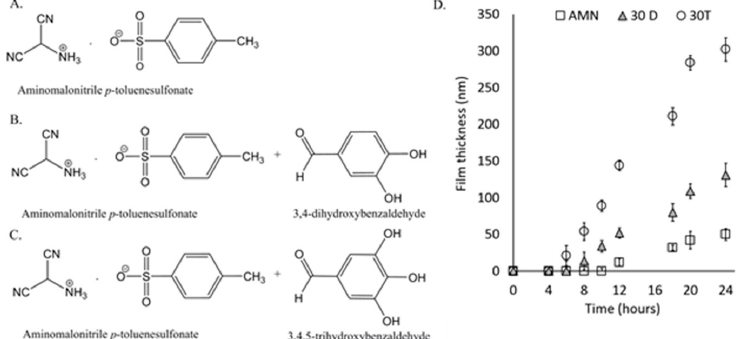
Figure 2. Structure of the parabenzenesulfonate salt of AMN (A). Addition of benzaldehydes: dihydroxybenzaldehyde (B) and 2,3,4-trihydroxybenzaldehyde (C) and the coating thickness achieved over time using these components (D). Here, AMN refers to 100 mol% aminomalononitrile, while 30D refers to 30 mol% 2,3-dihydroxybenzaldehyde and 70 mol% aminomalononitrile and 30T refers to 30 mol% 2,3,4-trihydroxybenzaldehyde and 70 mol% aminomalononitrile. Reproduced with permission from [13], Copyright American Chemical Society, 2017.